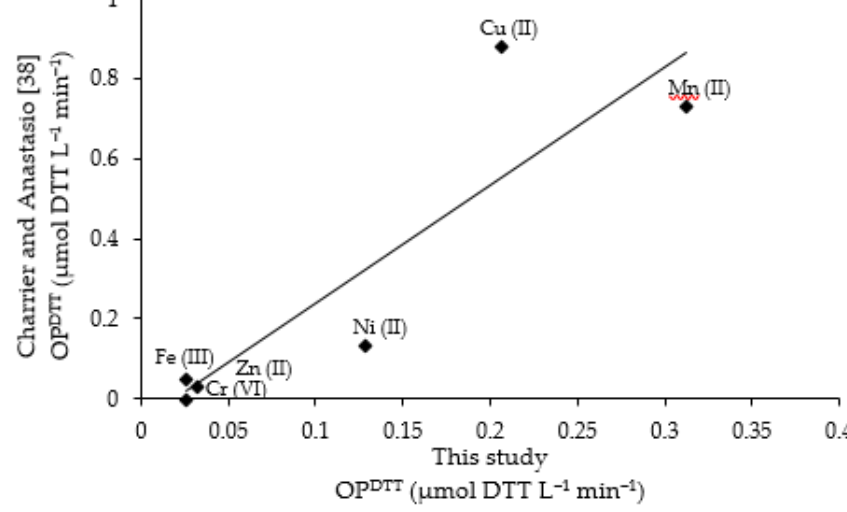
Figure A2. Scatter plot showing the positive correlation between OP DTT ( µ mol DTT L − 1 min − 1 ) measured in this study and in Charrier and Anastasio [38] for each metal at 1 µ mol L − 1 (in ascending order: Cr (VI), Zn (II), Fe (III), Ni (II), Cu (II), and Mn (II)).